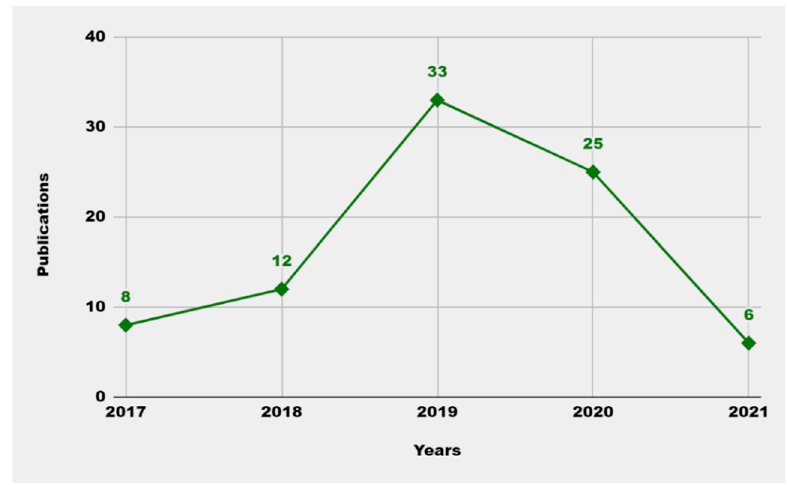
Figure 3. Number of publications per year.